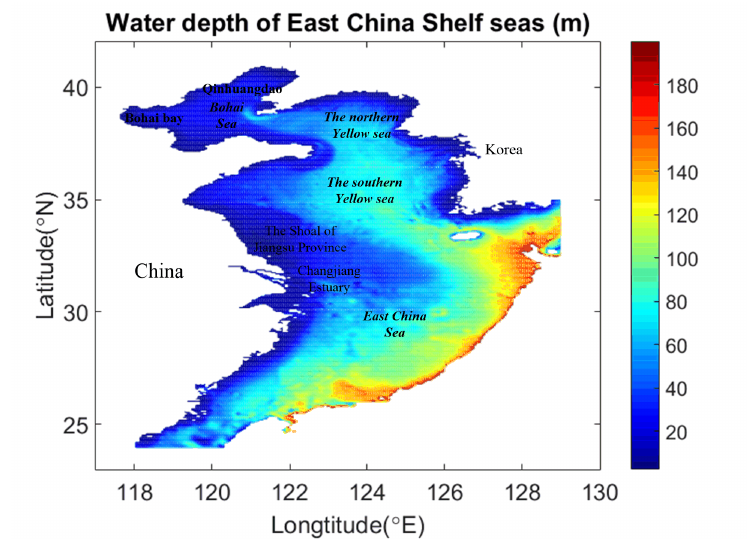
Figure 1. Depth map of East China Shelf Seas.